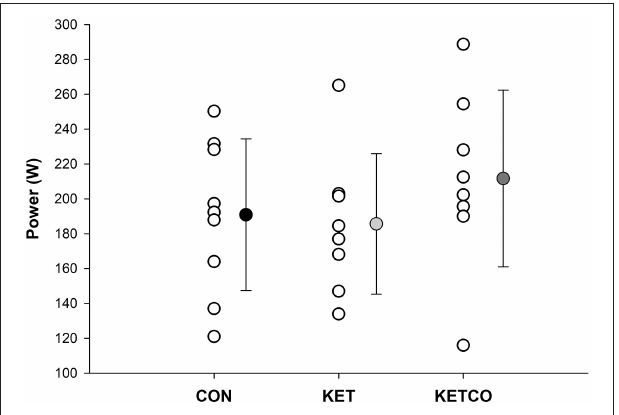
FIGURE 2 | Mean power output during each experimental time trial.